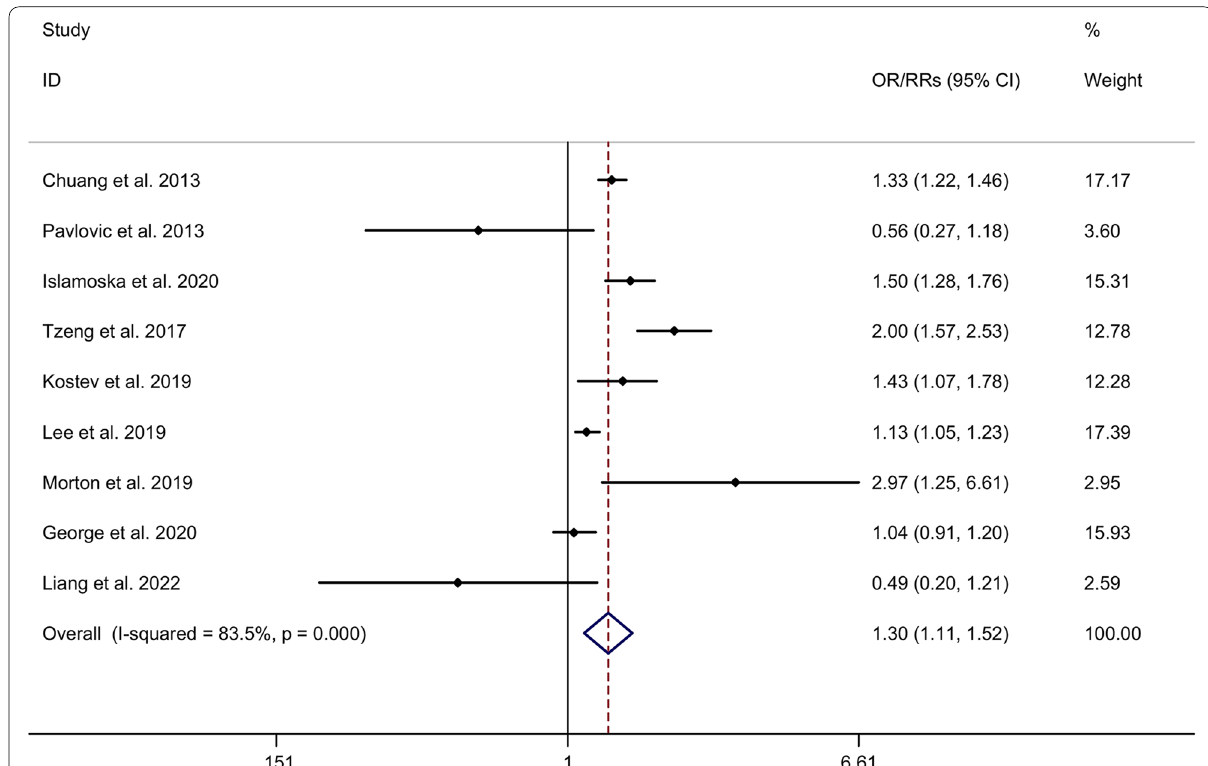
Fig. 7 Forest plots regarding association between migraine and risk of dementia. Abbreviations: CI, confidence interval; OR, odds ratio; RR, relative